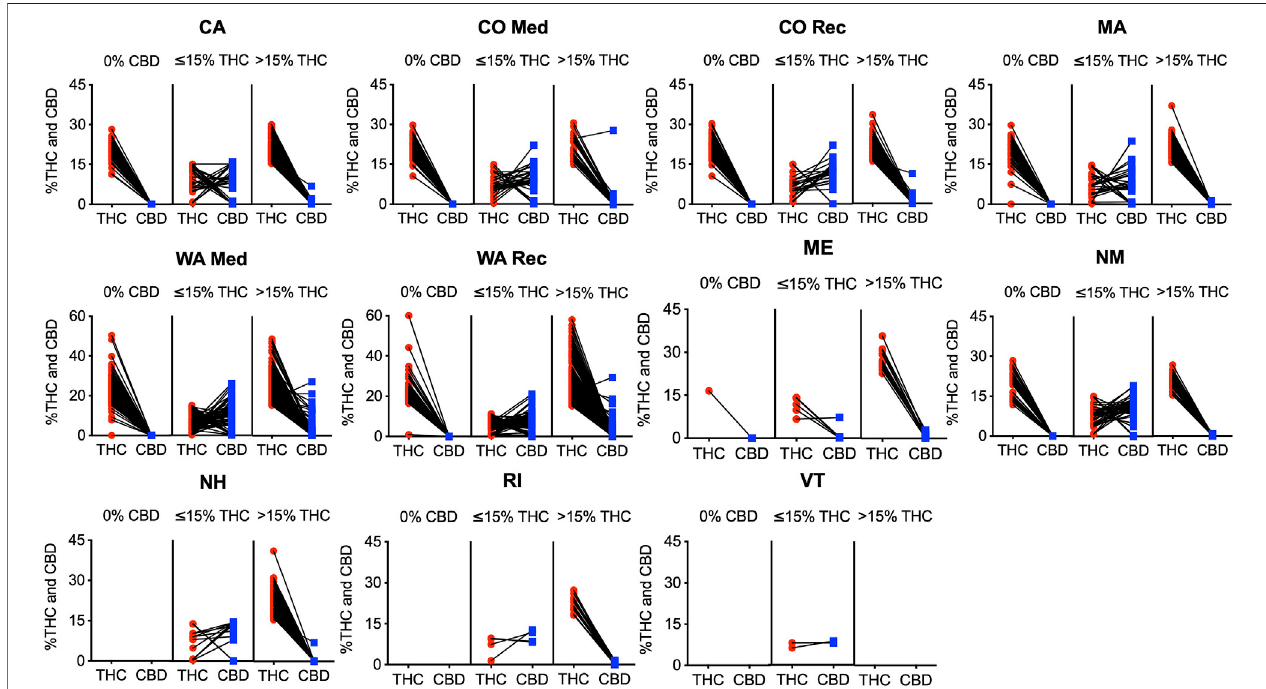
FIGURE 4 | All individual products with CBD content information with corresponding THC and CBD percentage in each state. The fi rst column for each graph contains all products with 0% CBD and their corresponding THC content; the second and third columns contain products with > 0% CBD, with the second column containing products with ≤ 15% THC, and the third column containing products with > 15%